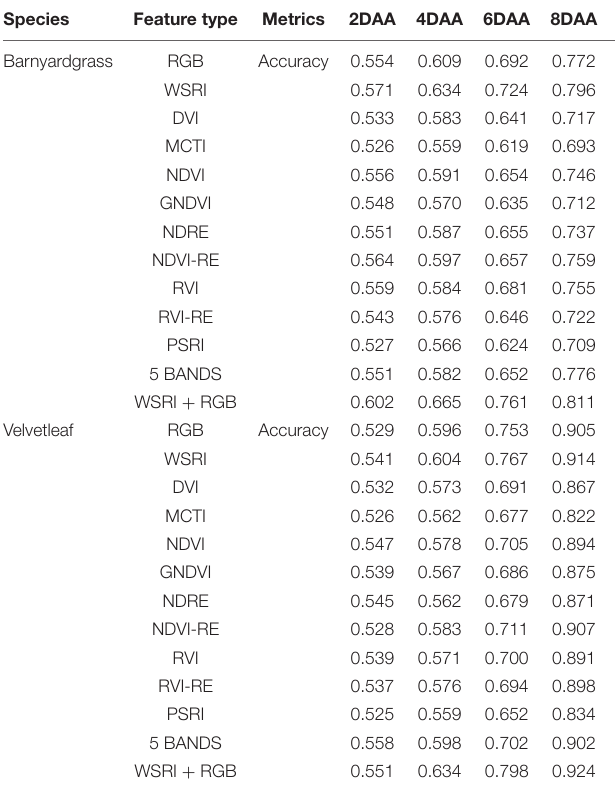
TABLE 4 | Resistant weed classification performance summary.